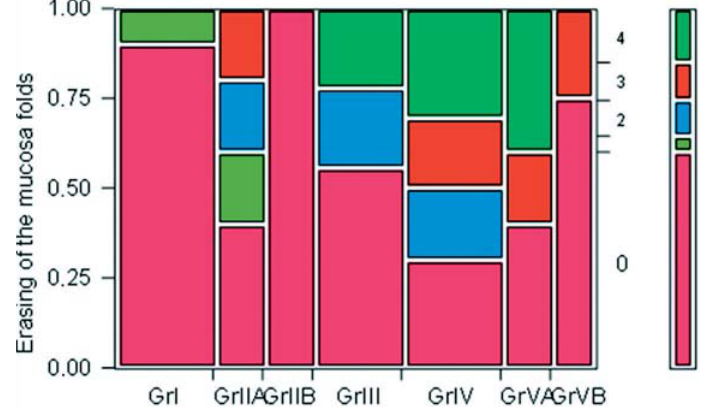
Figure 8- Macroscopic observation of the gastric mucosa in relation to parameter - Erasing of the mucosa folds